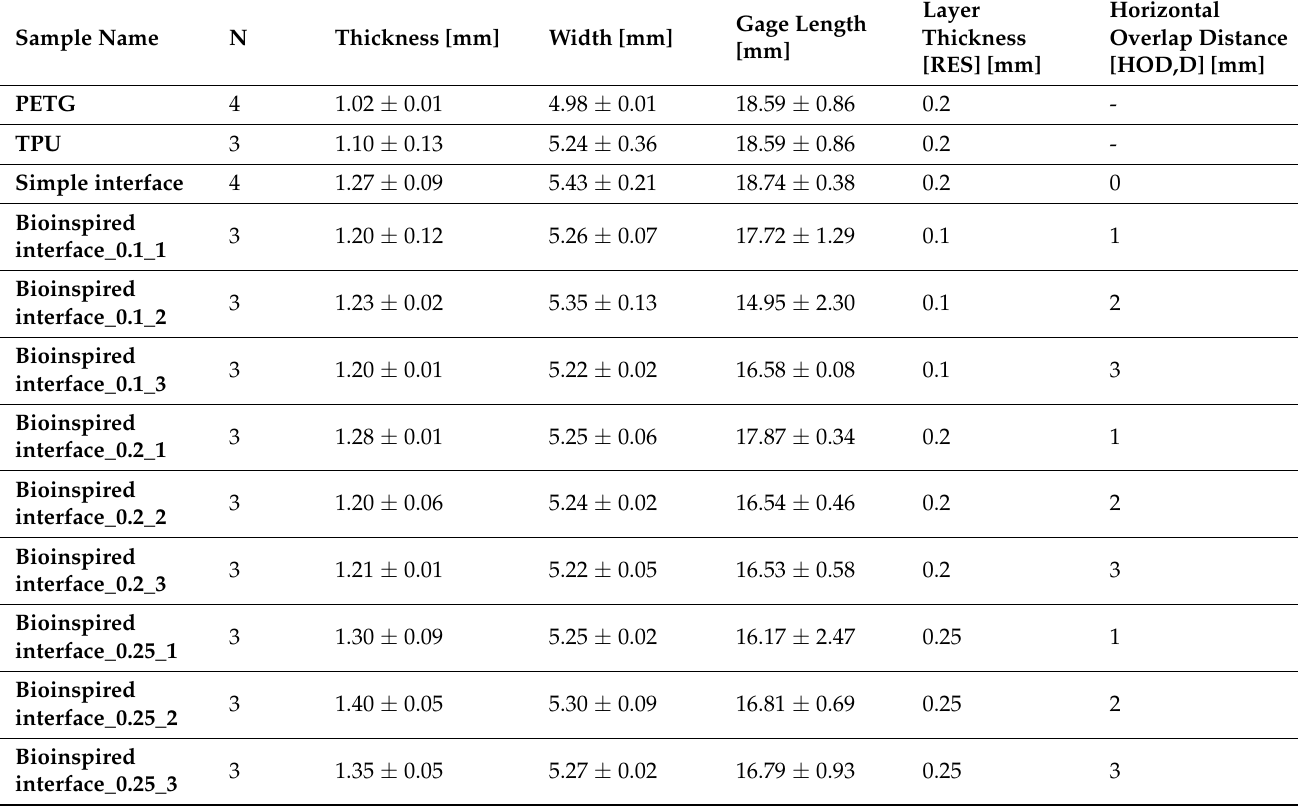
Table 1. Sample description and